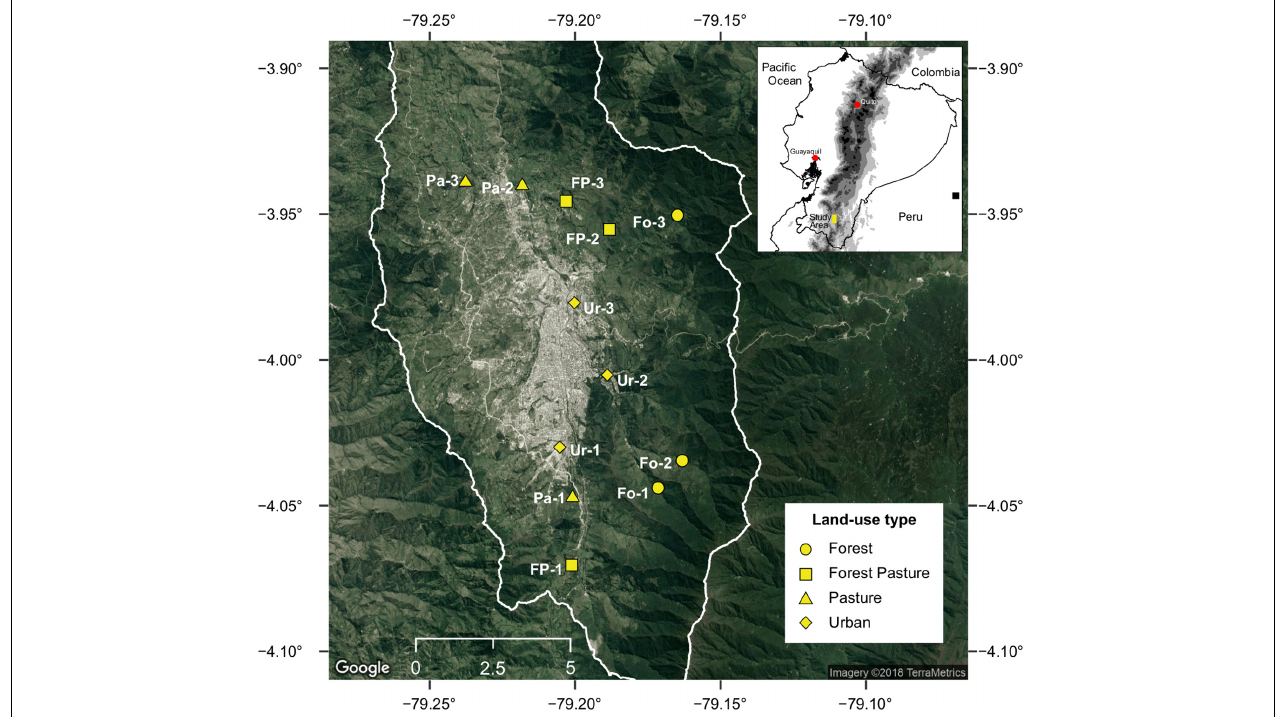
FIGURE 1 | Location of the study area, the city of Loja, and the sampling sites (yellow symbols) within different land-use types in southern Ecuadorian Andes. Fo, forest; FP, forest-pasture; Pa, pasture; Ur, urban. Modified from Chuquimarca et al. (2019).